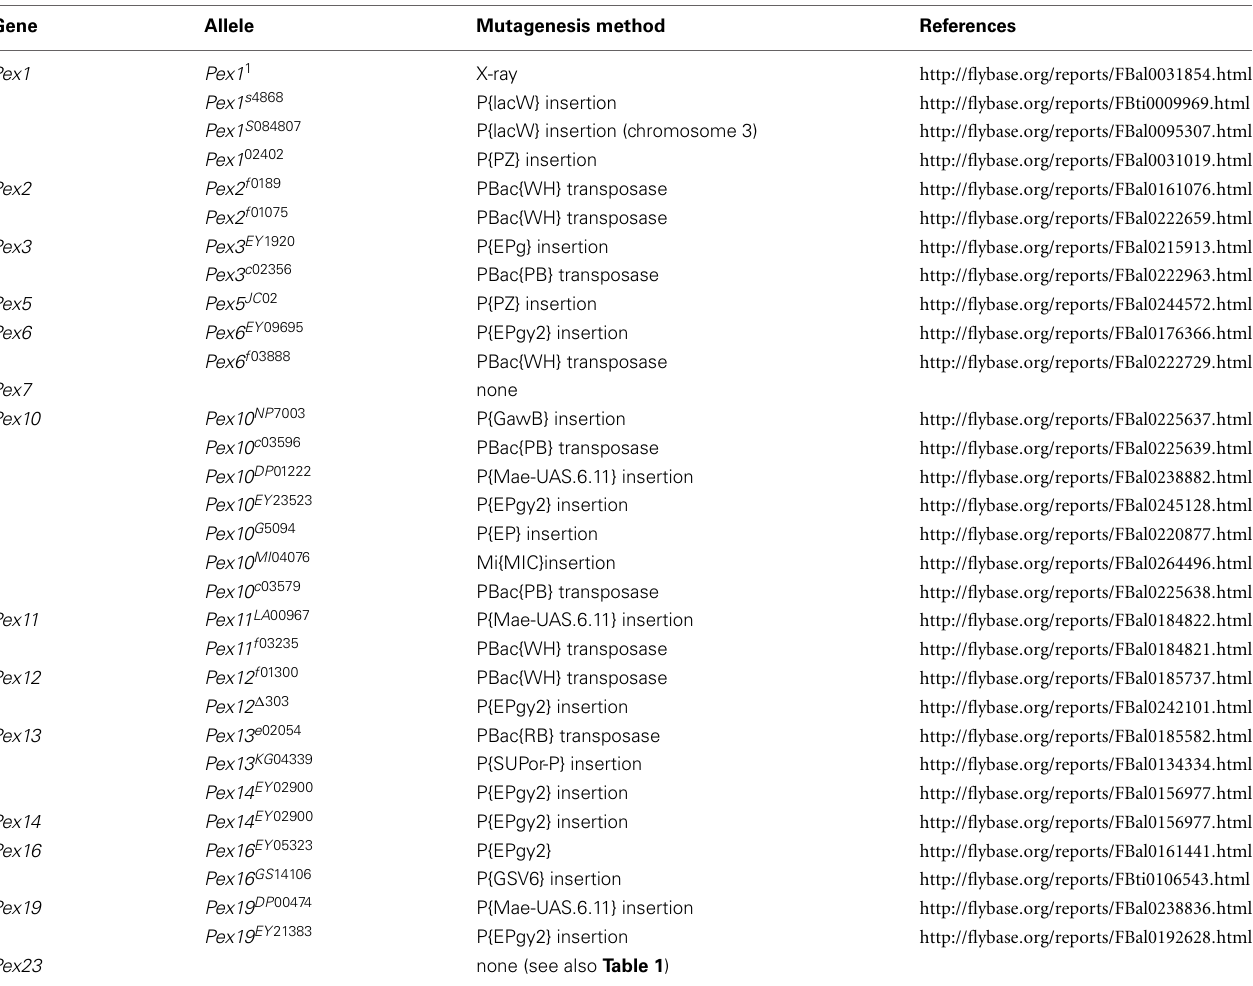
Table 3 | Overview of classical peroxin alleles in Drosophila melanogaster .